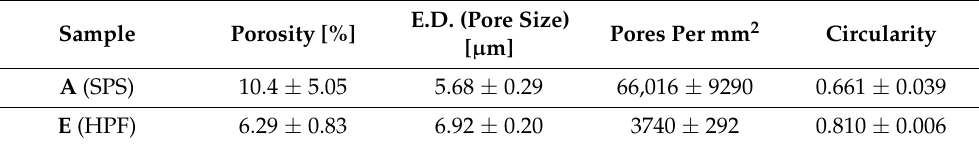
Table 3. Porosity details, based on image